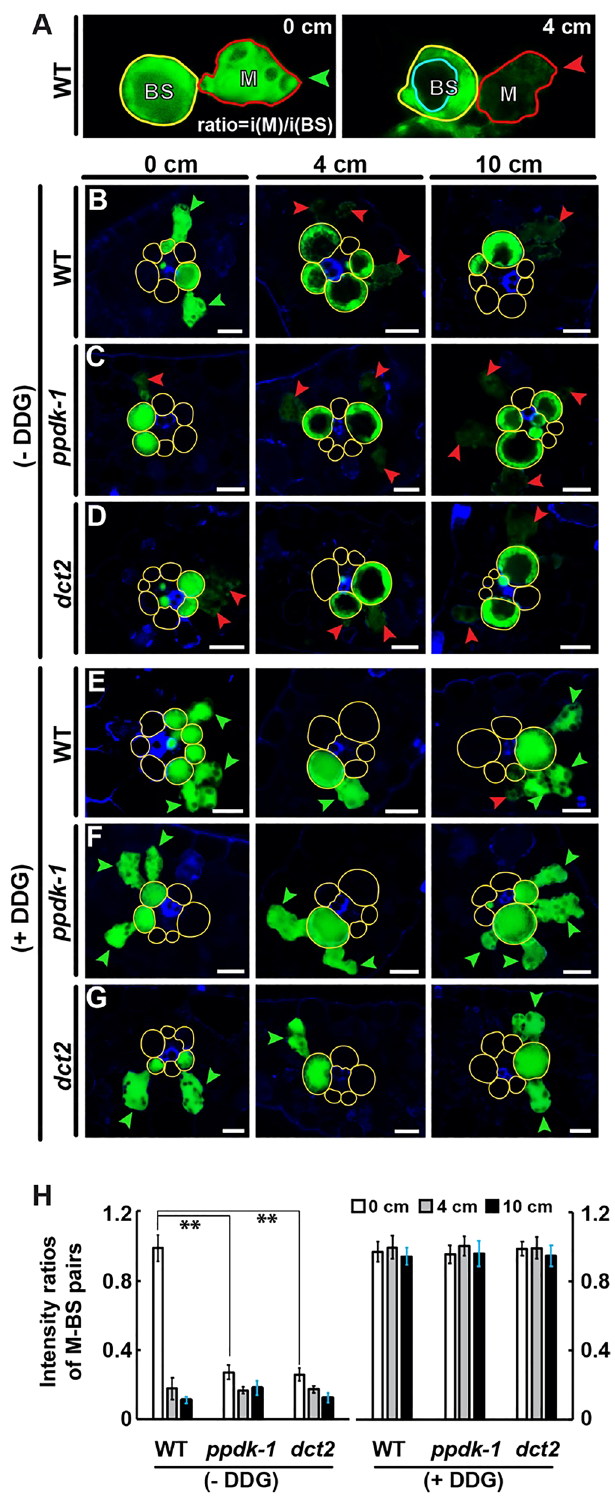
Figure 5. CFDA movement assay. (A) Confocal laser scanning micrographs of CFDA fluorescence (green) in WT leaf cross sections (0 and 4 cm). Typical M-BS pairs at 0 cm (left) and 4 cm (right) in WT leaf cross sections emit CFDA fluorescence. Green arrowhead marks fluorescence in M cell comparable to that in BS cell. Red arrowheads indicate faint fluorescence in M cell. Light blue compartment indicates central vacuole. (B–G) WT, ppdk-1 , and dct2 leaves ( B–D ) without DDG or ( E–G ) with DDG. M-BS units in which the M cells display fluorescence comparable to (less than 30% reduction) the BS cell are denoted with green arrowheads. Red arrowheads mark M cells in which fluorescence is weaker (less than 30% that in BS cell). Note that M cells in the 0-cm ppdk-1 and dct2 sections do not contain dye. BS cell walls are highlighted with yellow lines. Scale bars: 25 µm. (H) CFDA fluorescence ratios in M-BS units. The fluorescence intensities from the cytosols of M and BS cells were quantified to determine ratios. Central vacuoles were excluded when intensities were calculated ( ** , p < 0.01; Student’s